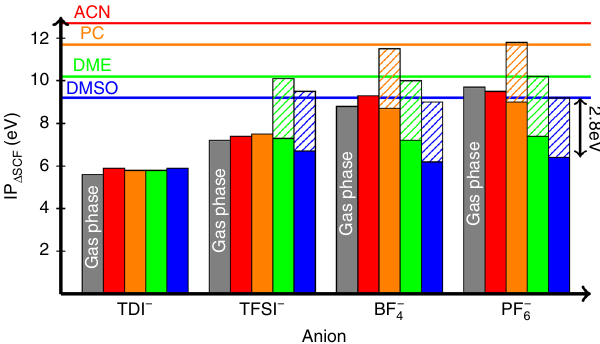
Fig. 2 IP of pairs of one anion and one solvent molecule with respect to the isolated species. Bars represent the average over 30 con fi gurations of each pair, with the x -axis showing the anion and the color indicating the solvent used (blue: DMSO; green: DME; orange: PC; red: ACN; gray: isolated anion). Values for the isolated species ( y -axis for the solvent, gray bar for the anion) are averaged over 50 con fi gurations. Dashed bars represent constant shifts δ = 2.8 eV (drawn for pairs where the solvent is oxidized). IPs are well approximated by Eq. (1): the smaller of anion IP or the solvent IP minus